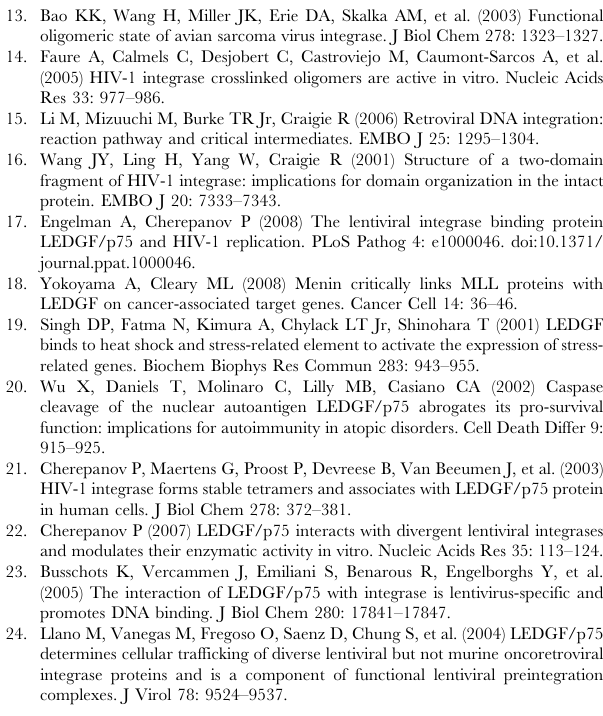
(black curves). Association of the two dimers during synaptic complex assembly involves a swap of an NTD from each dimer to interact with a CCD from the opposing dimer. When loaded, LEDGF would engage the CCDs from one dimer and an NTD from another, effectively stabilizing the complex. Further, it is also speculatively possible that the other NTD interacts with the IBD, as seen with the dark blue NTD in (A). (D) Alternative model for the assembly of the synaptic complex in which there is no NTD swap. In this case the IBD of LEDGF stabilizes the synaptic complex by locking the NTDs in the correct orientation for tetramerization. Figure S4 Validation of LEDGF-Dependent Concerted HIV-1 IN Strand Transfer Activity. (A) Increasing input of donor DNA favors concerted integration. Lane 1 contains a mock sample, where IN and LEDGF were omitted; lane 2 shows activity in the absence of LEDGF; lane 3 contained both LEDGF and IN, but no donor DNA. Lanes 4–9: HIV-1 IN was incubated with 1 m M- 4 nM (as indicated) blunt 32-bp donor DNA mimicking the U5 HIV-1 cDNA end and supercoiled target DNA in the presence of LEDGF. (B) HIV-1 IN strand transfer inhibitor MK0518 (Raltegravir) effectively blocks accumulation of full- and half-site reaction products. Lanes 4–9: HIV-1 IN was incubated with 0.5 m M pre-processed 32-bp donor DNA in the presence of LEDGF and MK0518 at final concentrations of 1,400 m M (lane 4), 140 m M (lane 5), 14 m M (lane 6), 1.4 m M (lane 7), 0.14 m M (lane 8), or 0.014 m M (lane 9). Almost complete suppression of half- and full-site integration is achieved at 1.4 m M MK0518, which is comparable to the concentration of IN (0.8 m M) used in this experiment. The inhibitor was not present in lane 3. Lane 1 contained a mock sample without IN and LEDGF; the cofactor was omitted from the reaction in lane 2. Migration positions of DNA size standards, DNA substrate, open circular (o.c.),